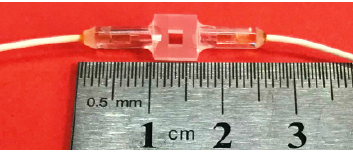
Figure 3. Photograph of the all-solid-state integrated fiber-optic acoustic sensor (FOAS).